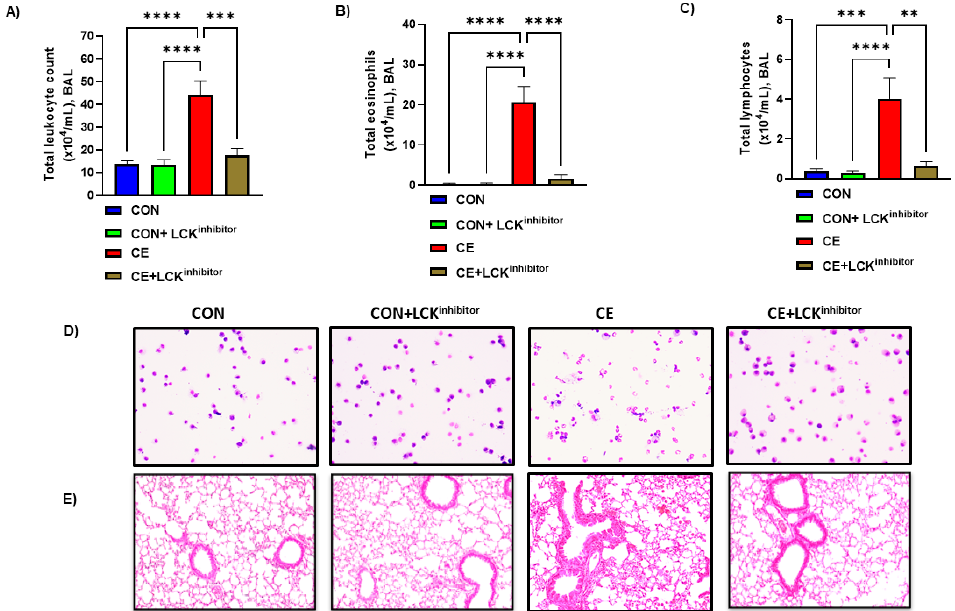
Figure 2. Amelioration of allergic airway inflammation by LCK inhibitor in CE-exposed allergic mice. ( A ) Total leukocytes count in BAL, ( B ) Total eosinophils in BAL, ( C ) Total lymphocytes in BAL, ( D ) Diff-Quik staining of BAL cells, and ( E ) H&E staining of lung tissue. Data are presented as mean ± SE, n = 6–8/group. ** p < 0.01; *** p < 0.001; **** p < 0.0001.